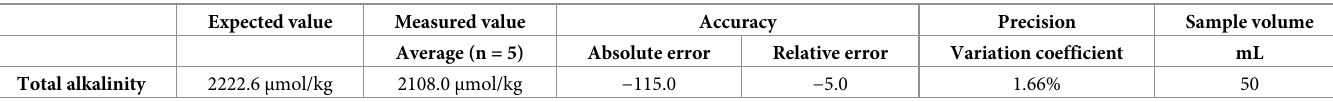
Table 3. Total alkalinity measured from 5 replicates of the certified reference material (Dickson, oceanic CO 2 measurements, batch 134). Expected value Measured value Accuracy Precision Sample